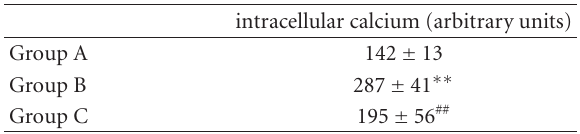
Table 2: (a) Intracellular Ca 2+ levels using fluorescence intensity. (b) Intracellular Ca 2+ levels using fluorescence